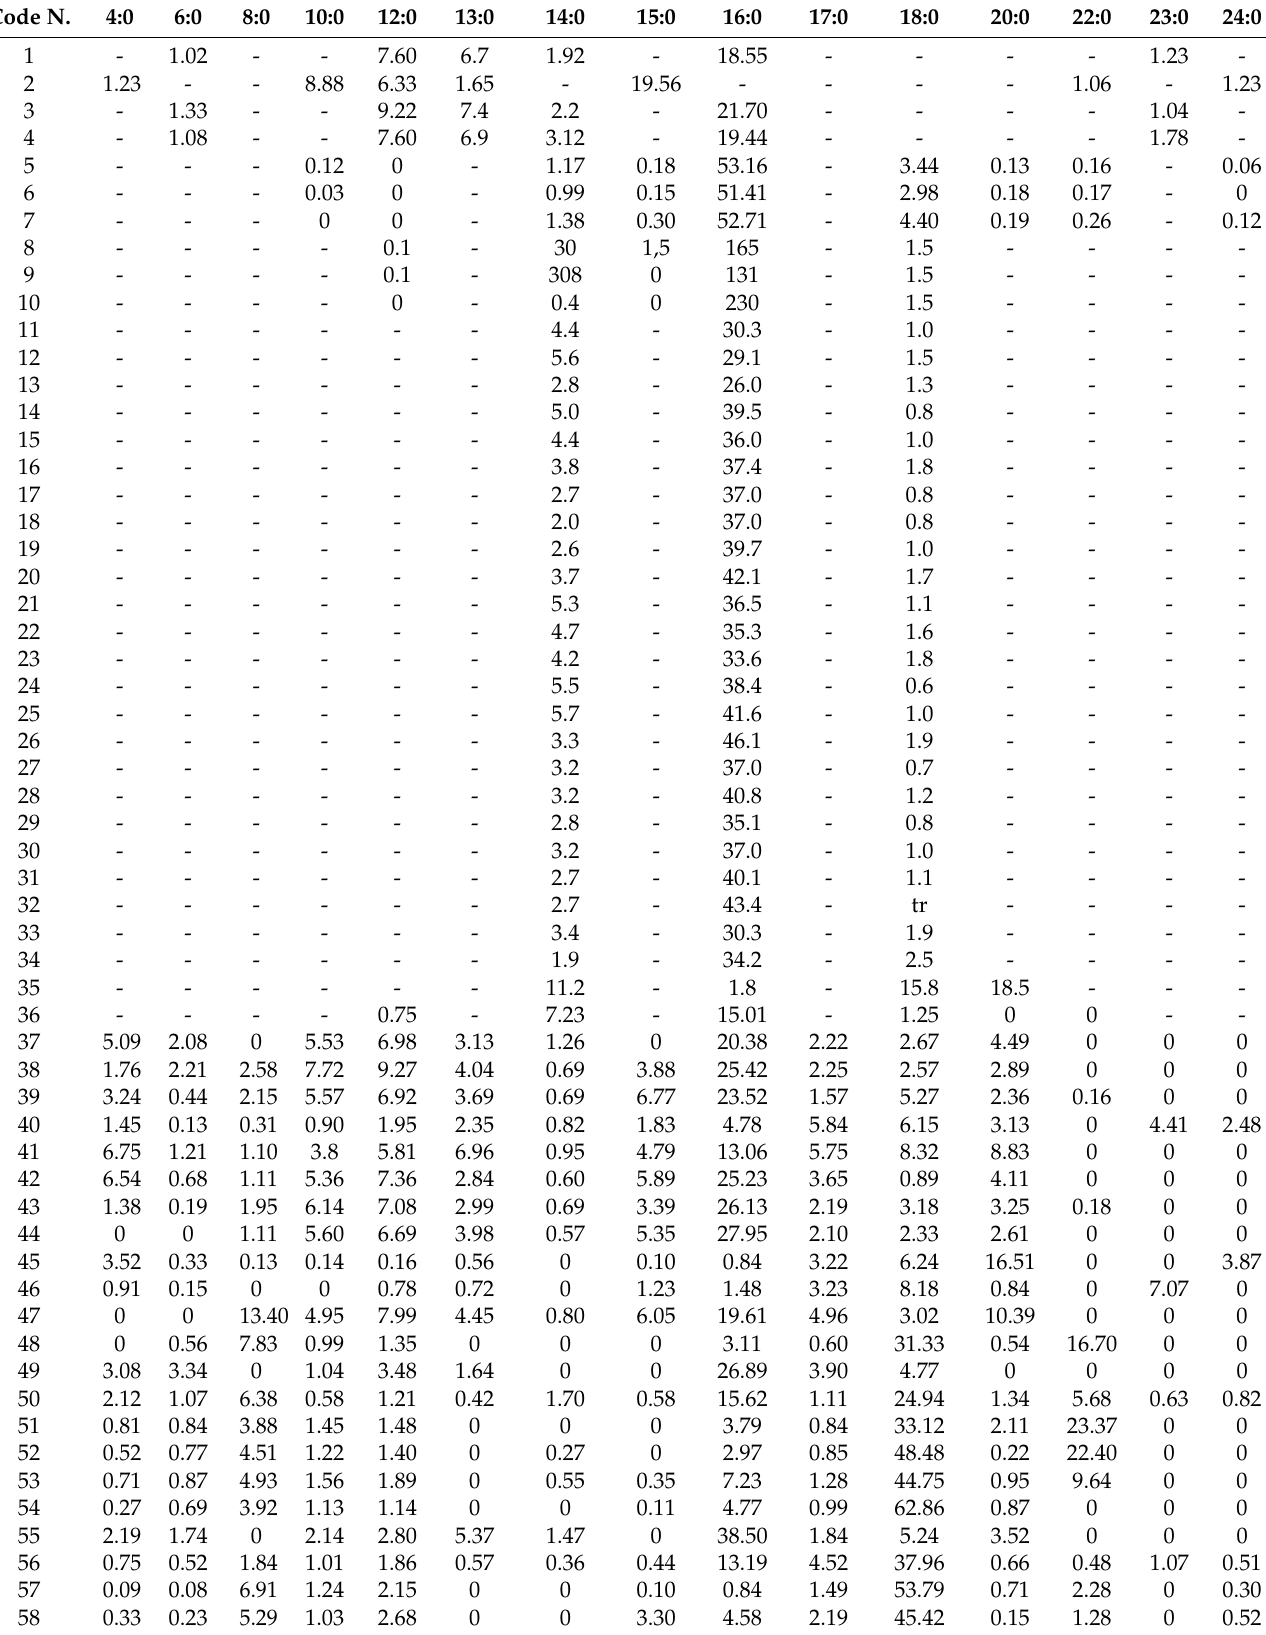
Table 2. Saturated fatty acid composition of cyanobacteria selected for this review 1,2